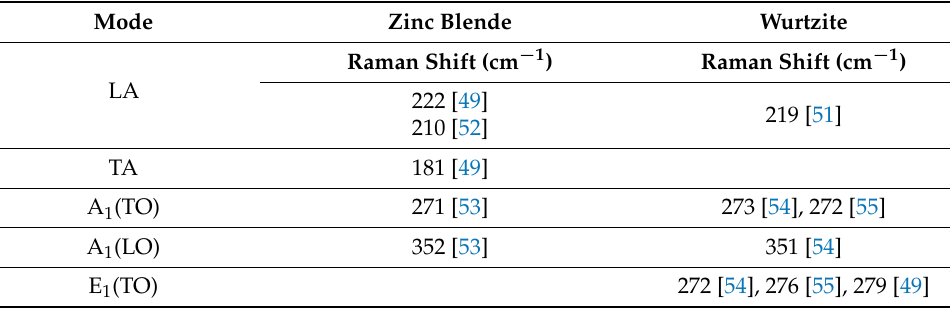
Table 4. Phonon modes assignment for the first and second order Raman spectrum.